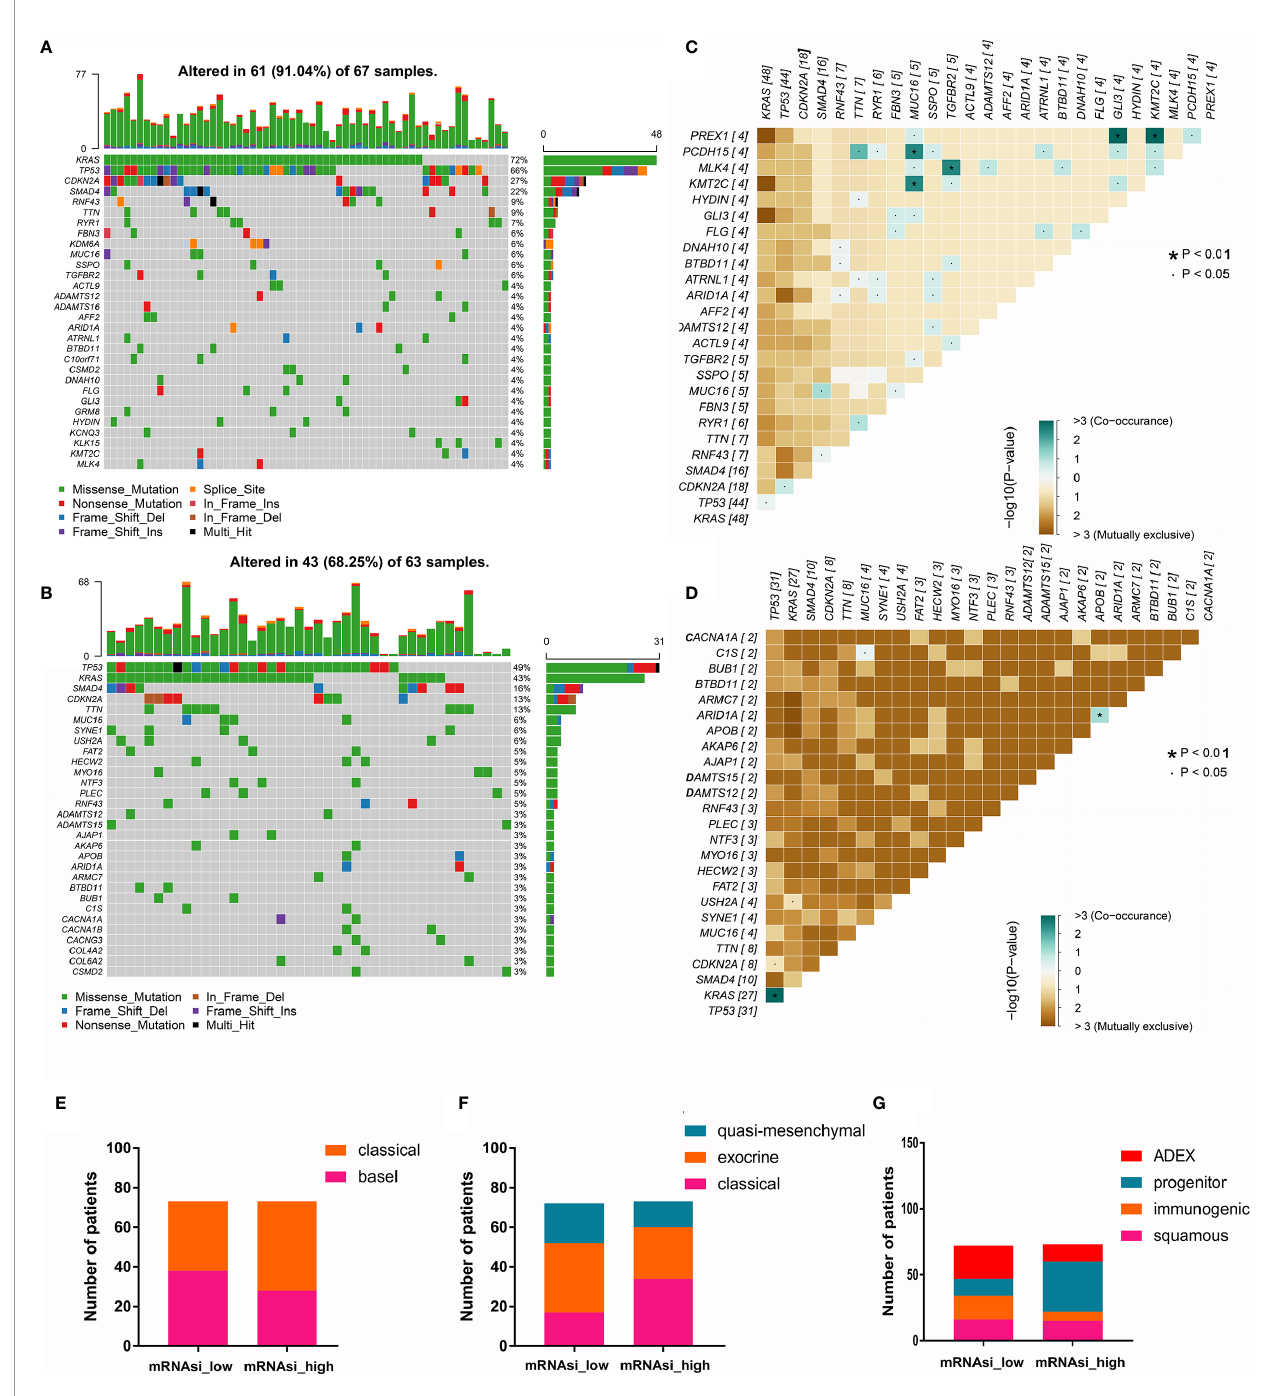
FIGURE 2 | The mutational landscape and molecular subtypes of samples with high and low mRNAsi values. (A, B) The top 30 most mutated genes in PDAC samples with high and low mRNAsi values. (C, D) Cooccurrence and mutual exclusion of mutated genes in PDAC samples with high and low mRNAsi values. (E – G) Proportions of PDAC samples of different molecular subtypes (Mof fi tt cluster, Collison cluster and Bailey cluster) with high and low mRNAsi